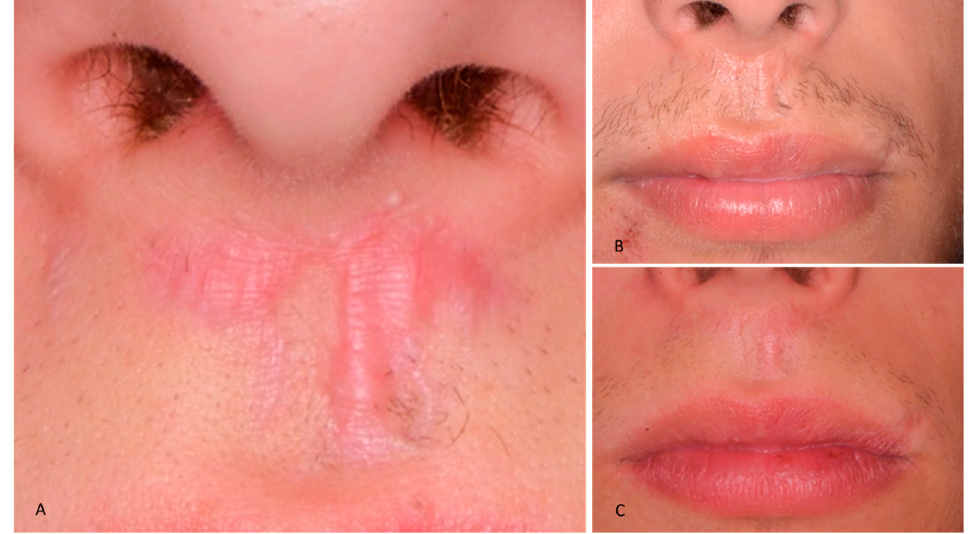
Figure 9. Extraoral view of the soft tissue healing after 1 month ( A ), two months ( B ) and 3 months ( C ) of phototherapy .